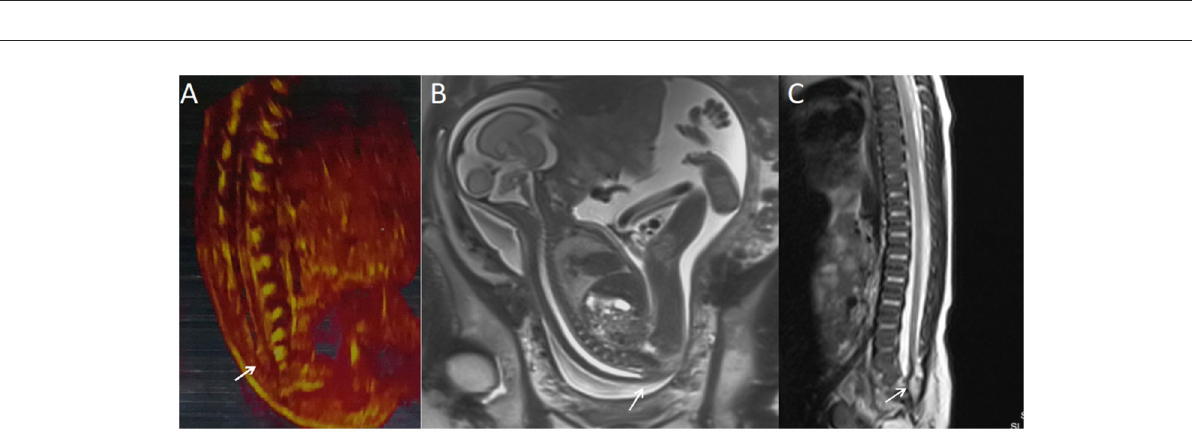
FIGURE2 A fetus with intraspinal lipoma. (A) The prenatal ultrasound examination at 25 + 1 weeks of gestation showed the presence of low conus medullosus in the fetus and hyperechoic mass shadow in the spinal canal. Thus, intraspinal lipoma was considered. (B) Fetal magnetic resonance imaging (MRI) examination at 25 + 2 weeks of gestation showed the low conus medullosus of the fetus, with enlarged end of the conus medullosus and conus terminal and dural sac caudal adhesion. (C) T2 sagittal MRI of the lumbosacral vertebrae 20 days after birth suggested spina bifida and intraspinal